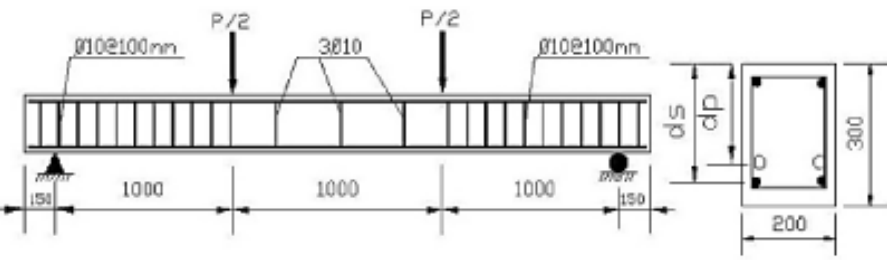
Fig. 4. Detail of beams reinforcement tested by Oukaili and Khattab